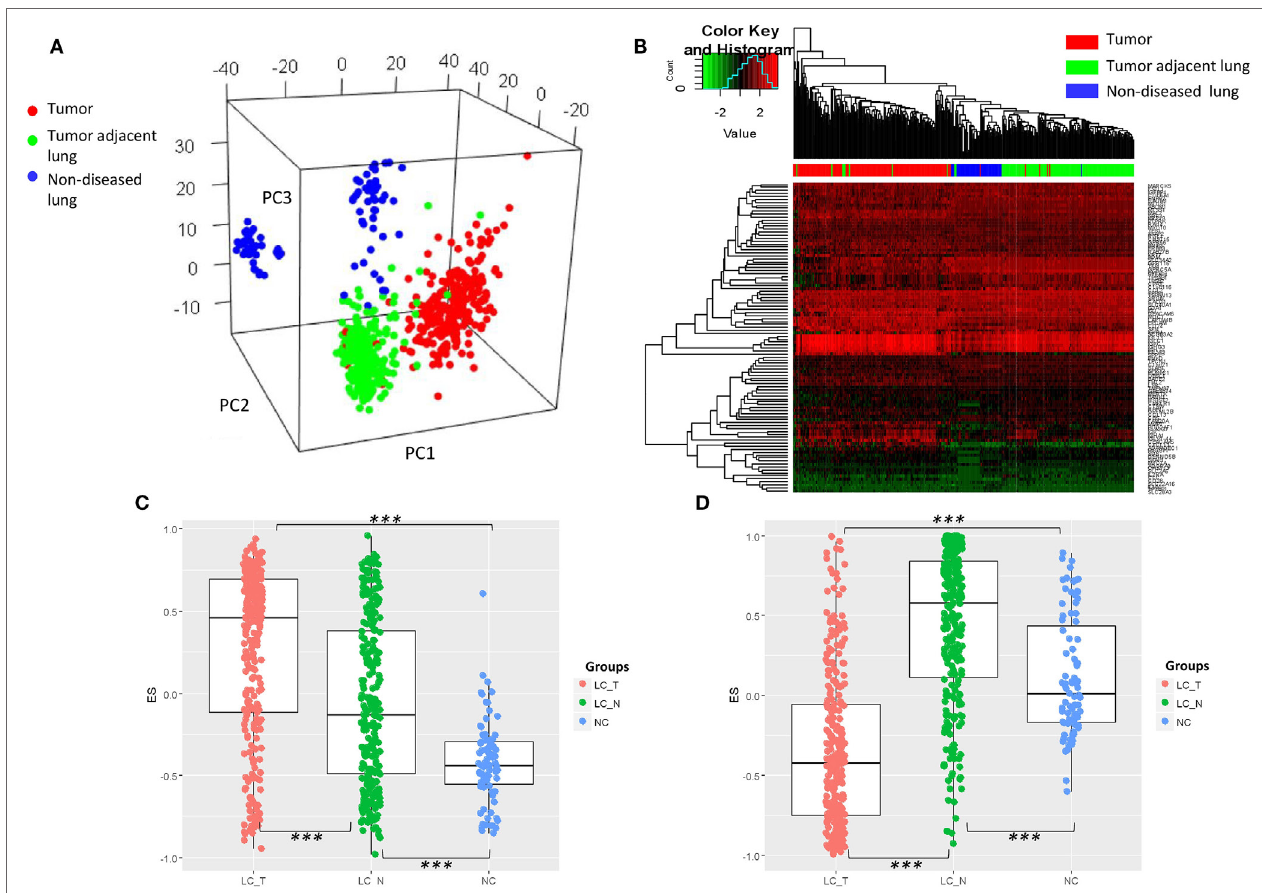
FigUre 4 | (a) Visualization of principle component analysis using the standardized expression matrix of differentially expressed genes of bronchoalveolar lavage cells extracted from eight datasets, which corresponded to the tissues of non-diseased lungs ( n = 87, blue), the tissues of human resected tumors ( n = 273, red), and the tissues of tumor adjacent normal lungs ( n = 247, green). (B) Unbiased clustering using the same expression matrix showing clear distinctions between the three tissue types, except for one sample of non-diseased lung tissue. Expression of the gene set from (c) the composite of immunoglobulin genes and (D) the genes of mast cell proteinases CPA3, TPSAB1, and TPSB2 . LC_T, resected tumor; LC_N, tumor adjacent normal lung; NC, normal control non-diseased lung, *** p < 2.0 × 10 − 7 by Tukey HSD